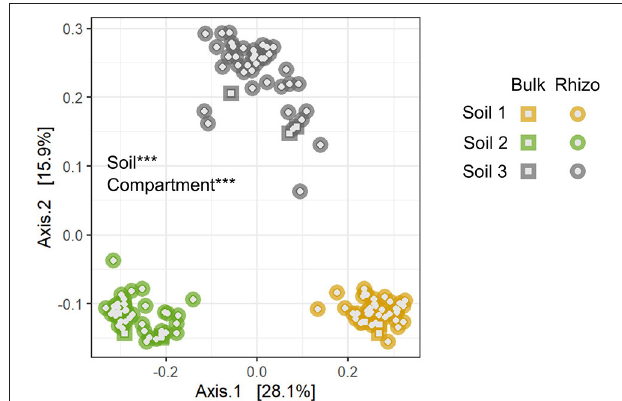
FIGURE 2 | The three soil types differed significantly in bacterial community composition. Asterisks indicate main factors that contribute significantly to compositional variation among samples (*** p < 0.001) by Bray-Curtis distance, tested by PERMANOVA. Bulk, soil samples not associated with plants; Rhizo, soil samples collected from rhizospheres. Compartment refers to bulk vs. rhizosphere samples.